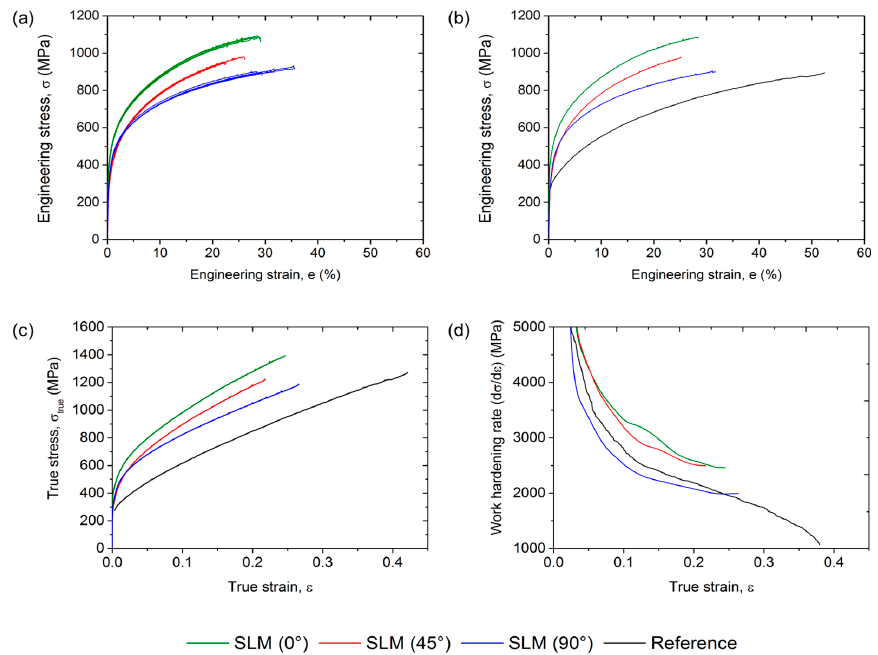
Figure 8. ( a ) Engineering stress-strain curves of all SLM-produced samples tested; ( b ) engineering stress-strain curves of selected SLM-produced samples of each condition in comparison with a reference steel; ( c ) true stress-true strain curves; and ( d ) work hardening rate-true strain curves. The reference sample refers to an X30Mn22 steel processed conventionally, whereas 90°, 45°, and 0° refer to the angle between tensile direction and scan direction, as shown in Figure 2.